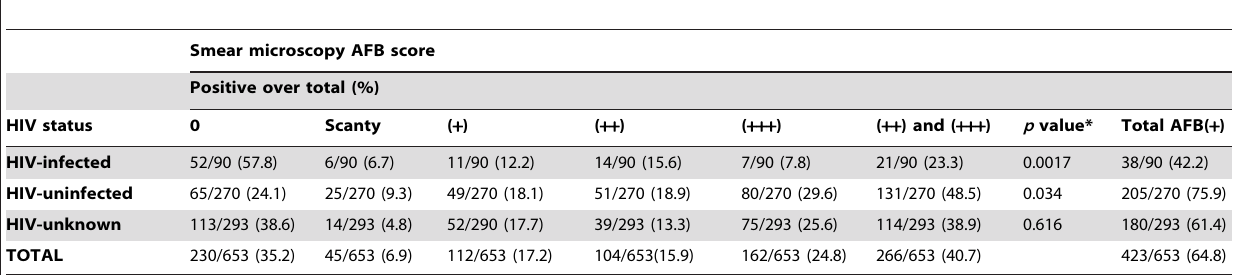
Table 8. Comparative proportions of the semi-quantitative smear microscopy results (AFB score) obtained in groups of patients with active pulmonary TB according to their HIV